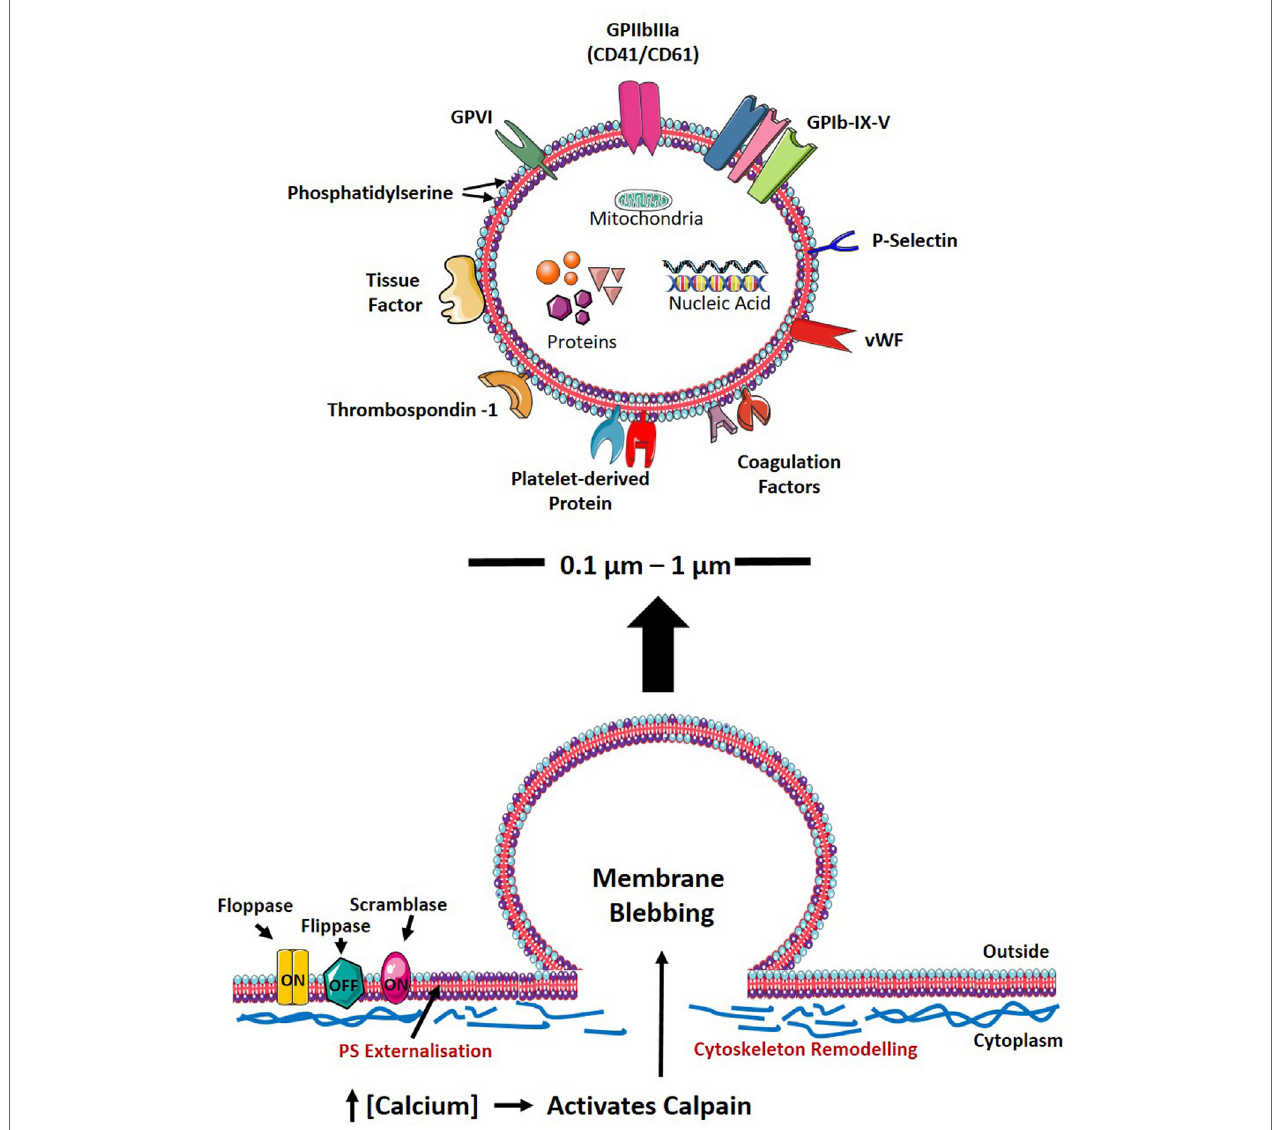
FiGURe 1 | PMV formation and characteristics. Upon cellular activation, the elevation of intracellular calcium inhibits flippase, while activating floppase and scramblase (TMEM16F), mediating the externalization of negatively charged PS (indicated as purple phospholipid). Furthermore, increased intracellular calcium leads to reorganization of the cytoskeleton by activating calpain, thereby cleaving PMVs and releasing them into the circulation. The size, physical characteristics, and cargo of PMVs depend on the environment and agonist(s) causing PMV generation. PMVs share many surface proteins with platelets such as integrins, selectins, adhesion receptors, coagulation factors, and other platelet-derived proteins. PMVs are packed with proteins including growth factors, cytokines/chemokines, and apoptotic proteins. PMVs also carry nucleic acids (mRNA, miRNA, and RNA) and mitochondria. PS, phosphatidylserine; GP, glycoprotein; vWF, von Willebrand factor; RNA, ribonucleic acid; mRNA, messenger RNA; miRNA, microRNA; PMV, platelet-derived microvesicle.